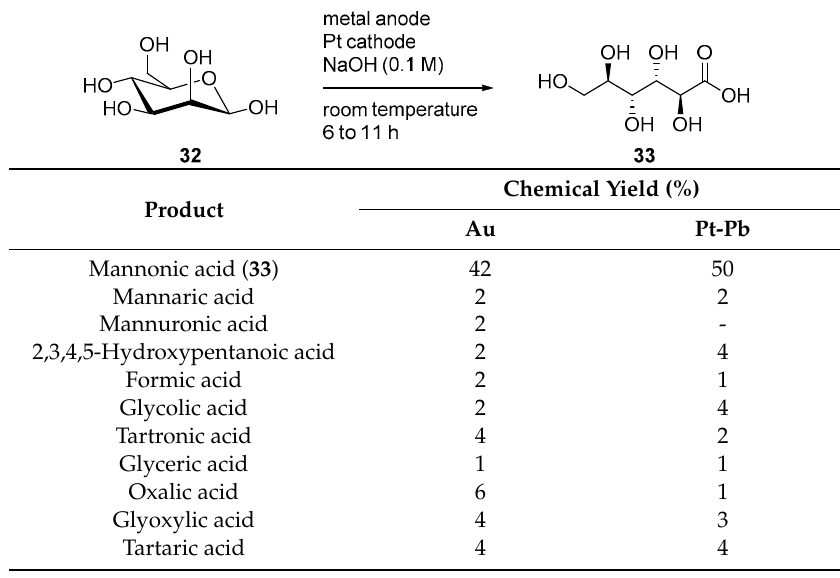
Table 7. Direct electro-oxidation of D -mannose ( 32 ).